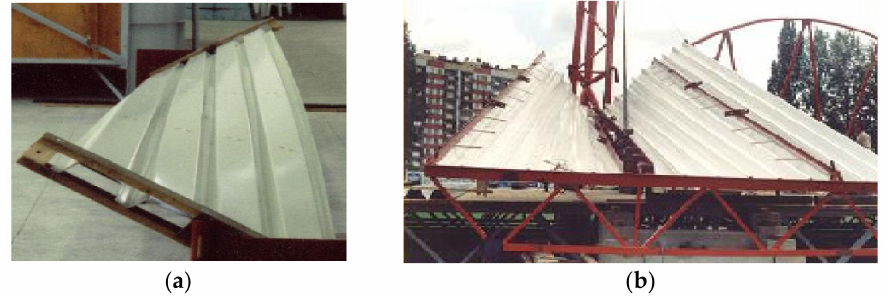
Figure 12. Transformed folded sheets characterized by: ( a ) free arched longitudinal edges; ( b ) stiff- ened straight edges.